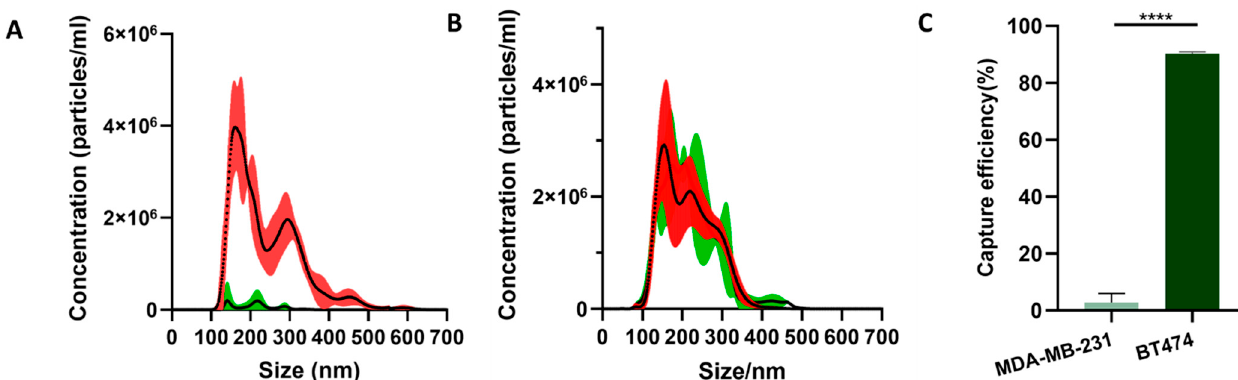
Figure 3. ( A – C ) NTA results for cell suspension of BT474 and MDA-MB-231. ( A ) Size distribution of particles before (red curves showing standard deviation) and after (green curves showing standard deviation) the BT474 suspension mixed with the HER2 antibody-coated microparticles. ( B ) Size distribution of particles before (red curves showing standard deviation) and after (green curves showing standard deviation) the MDA-MB-231 suspension mixed with the HER2 antibody-coated microparticles. ( C ) The capture efficiency of HER2 antibody-coated microparticles for BT474 suspension and MDA-MB-231 suspension, respectively. **** P < 0.0001.